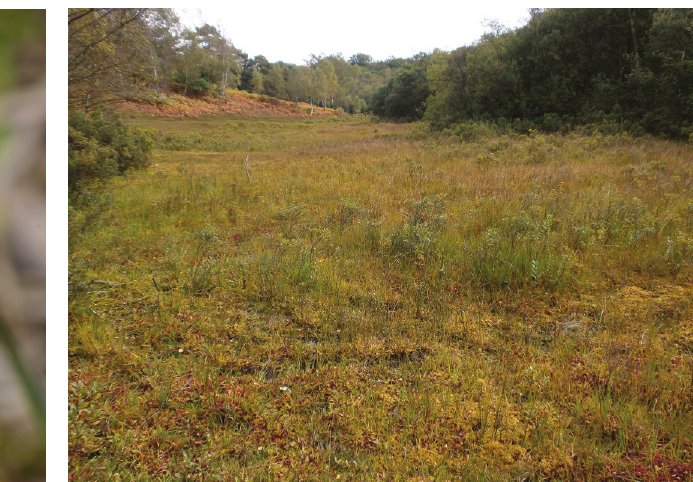
Fig. 3. Sphagnum -dominated mire in the New Forest, UK; habitat for Stethophyma grossum ; credit T. Gardiner .